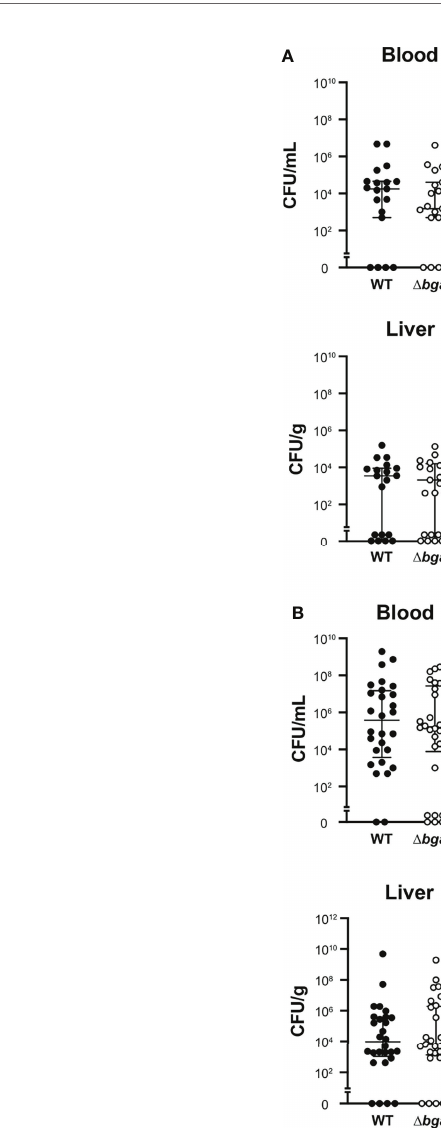
Figure 3 . Although genes encoding TNF- a , IL-1 b , IL-15, LIF, CSF-2 were down-regulated in RNA-seq analysis